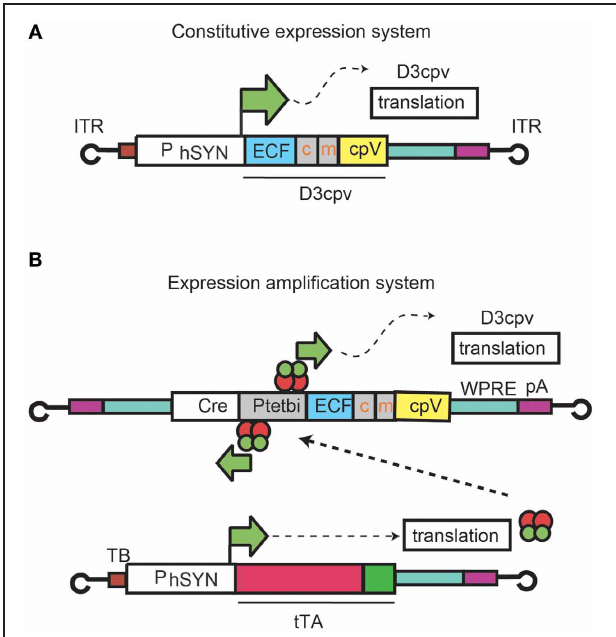
FIGURE 1 | rAAV expression systems for D3cpv. Expression under hSYN control (A) and an rAAV system consisting of two recombinant viruses where D3cpv is expressed under the control of P tet bi activated by the tetracycline transactivator tTA under hSYN (B)